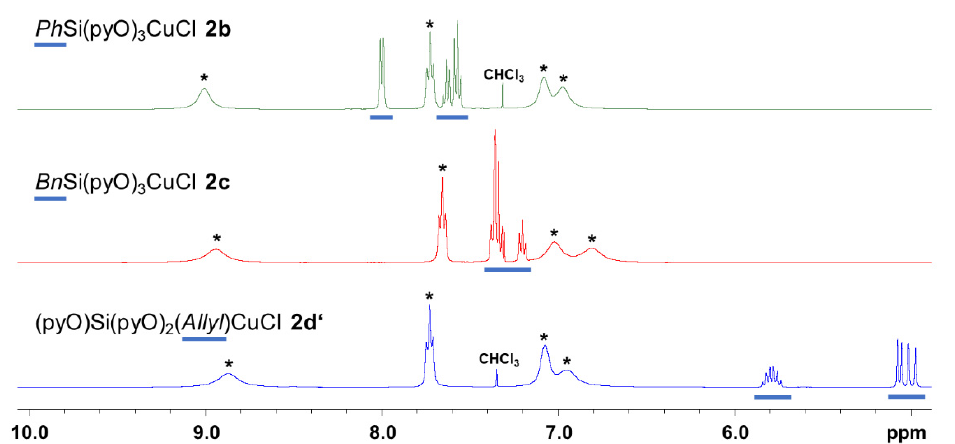
Figure 6. Aryl and olefin section of the 1 H NMR spectra of (from top to bottom) 2b , 2c and 2d ′ (as solutions in CDCl 3 , all referenced to internal SiMe 4 at 0 ppm, cf. Figures S9, S12 and S17 in the Supplementary Materials) recorded at 400 MHz. The asterisks (*) indicate corresponding signals of their pyO moieties, the underbars indicate the relevant 1 H signals of the different hydrocarbyl substituents Ph, Bn and Allyl, respectively.